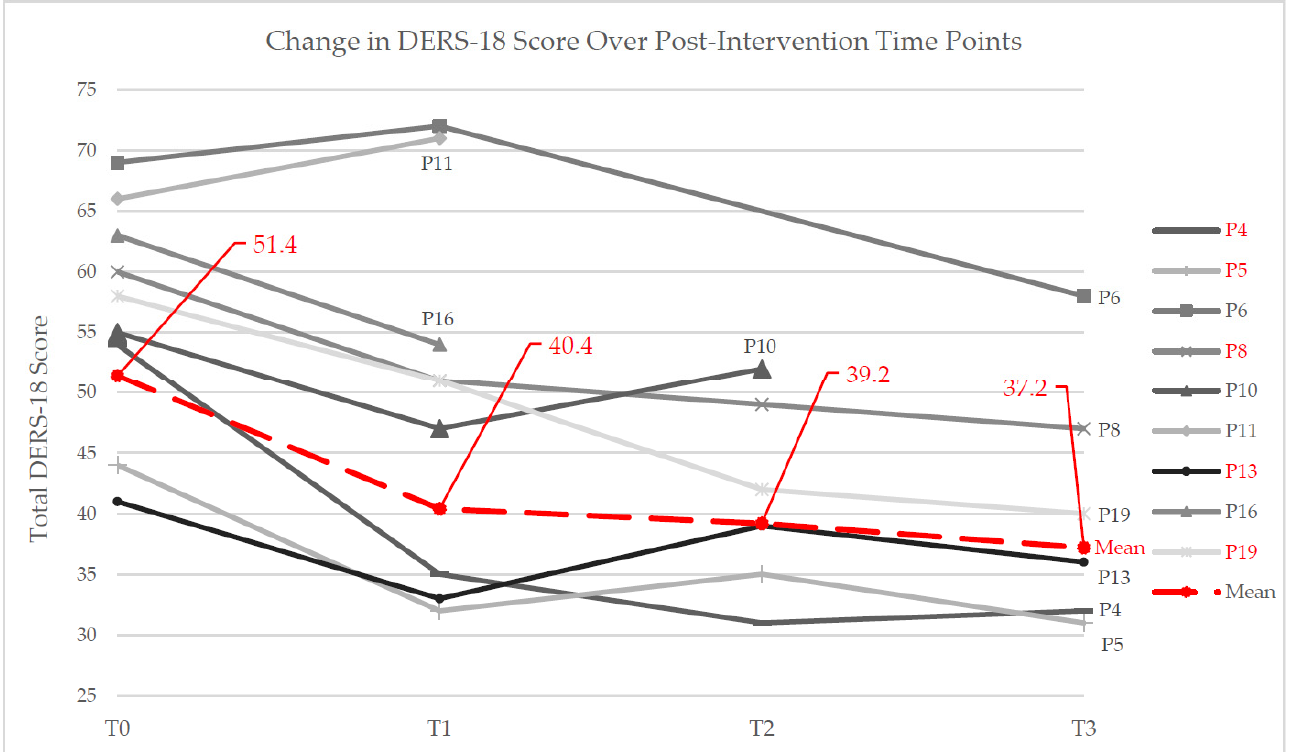
Figure 1. Changes in DERS-18 scores in participants across time. T0 denotes preintervention baseline. T1, T2, and T3 denote postintervention follow-up at 1 week, 1 month, and 3 months. Mean trendline (red dotted line) was calculated using five participants (P4, P5, P8, P13, P19) that had all three postintervention timepoints recorded (T1, T2, T3).